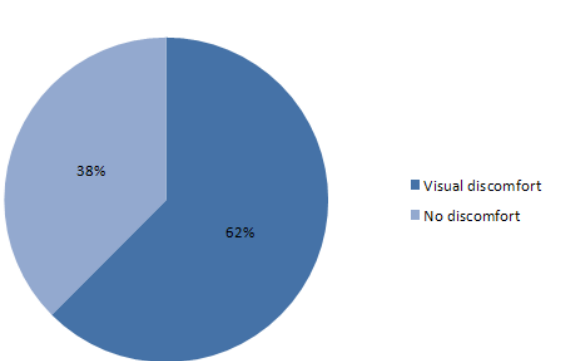
Fig. 12. Fraction of users who reported visual discomfort while using the HMD in the initial test.